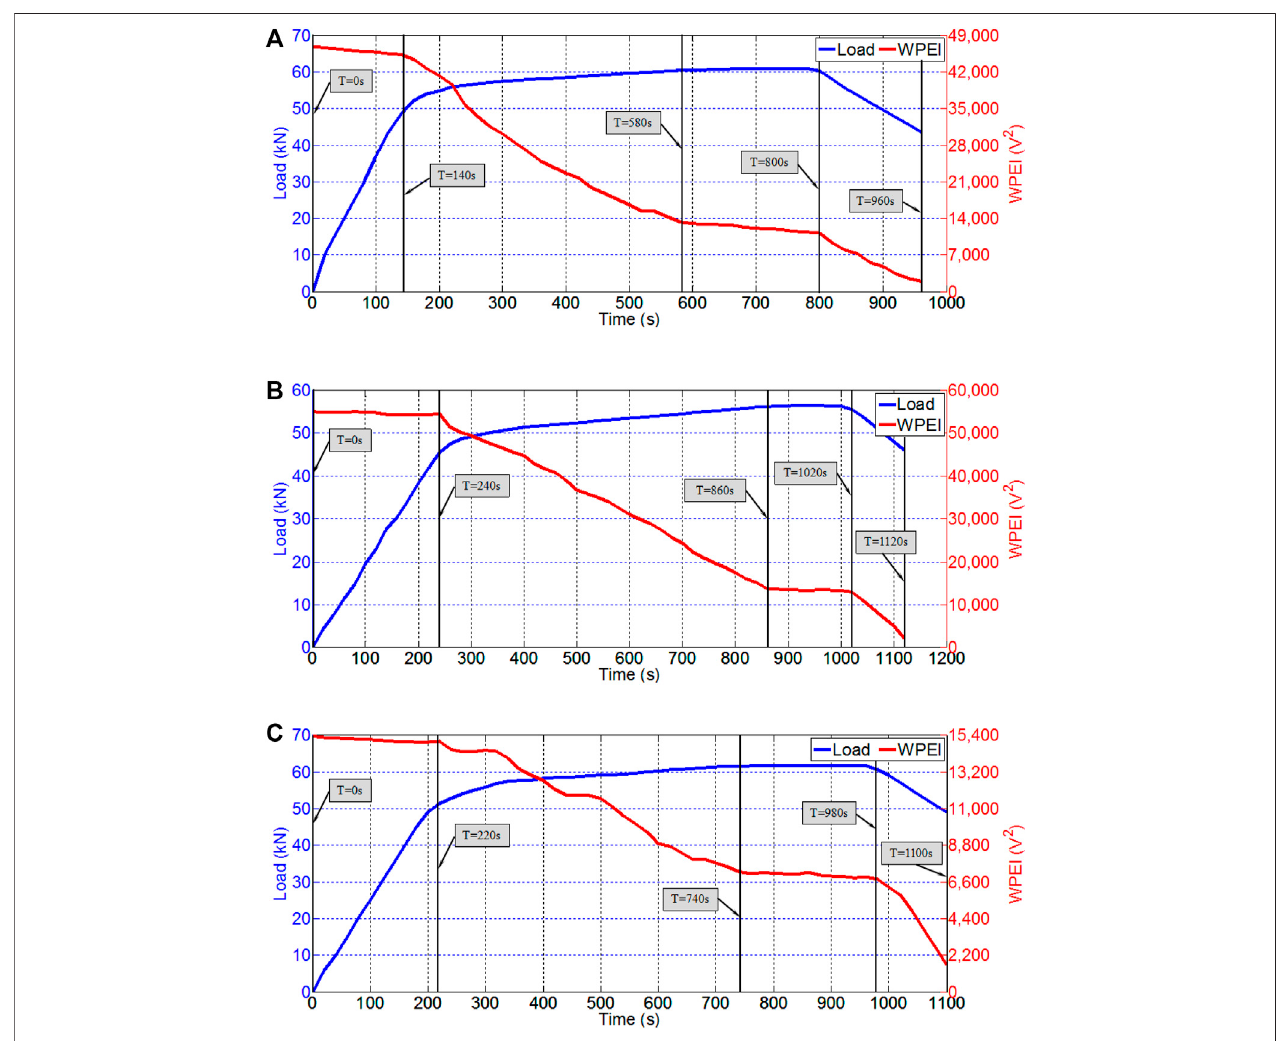
FIGURE 11 | The relationship between load and WPEIs for the three different specimens: (A) The relationship between load and WPEIs of S1; (B) The relationship between load and WPEIs of S2; (C) The relationship between load and WPEIs of S3.